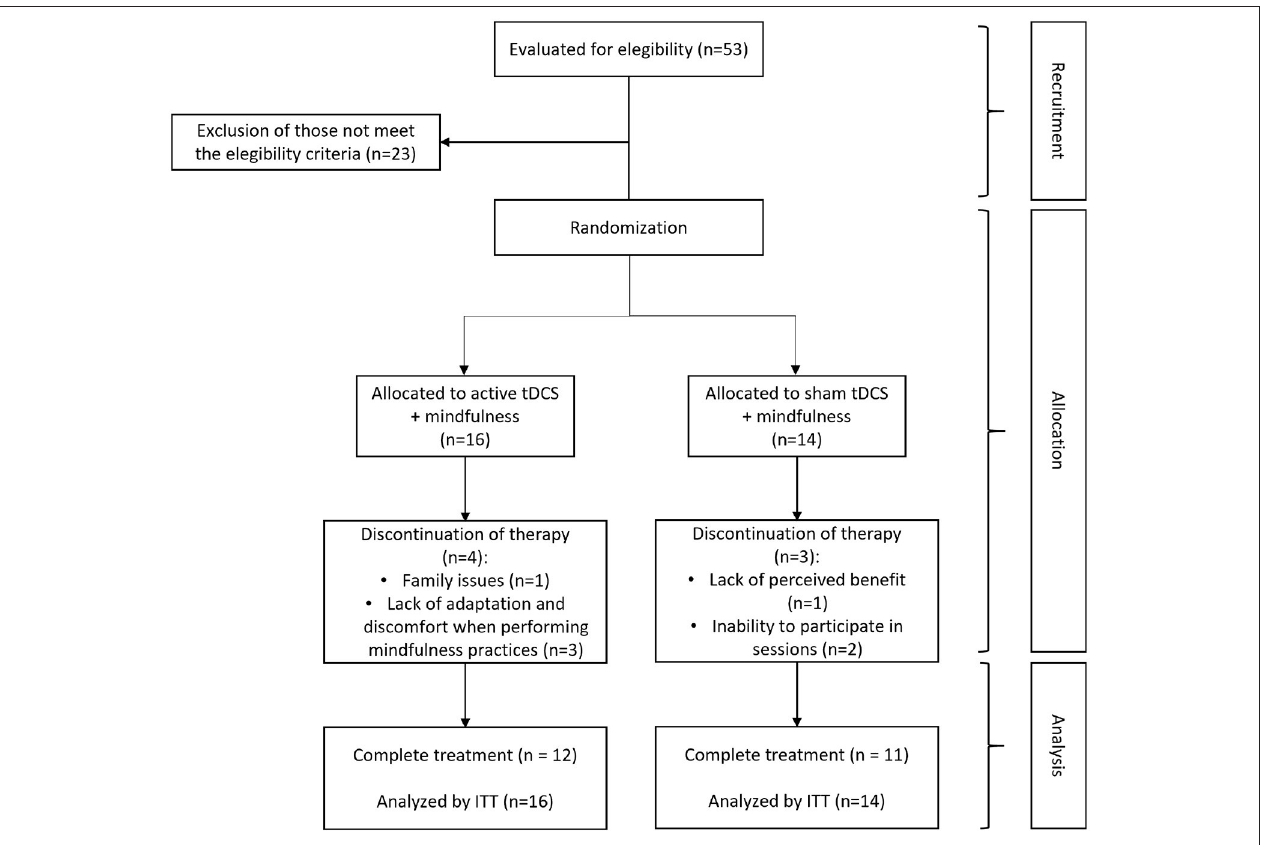
FIGURE 3 | CONSORT flowchart. n , quantity of participants; ITT, intention to treat.